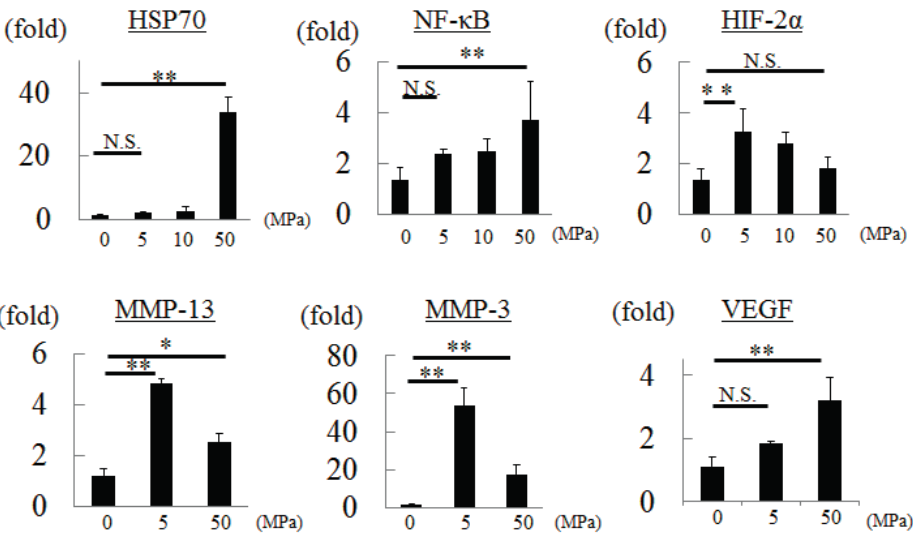
Figure 2. Gene expressions in chondrocytes after hydrostatic pressurization. * p < 0.05, ** p < 0.01, and N.S.: no